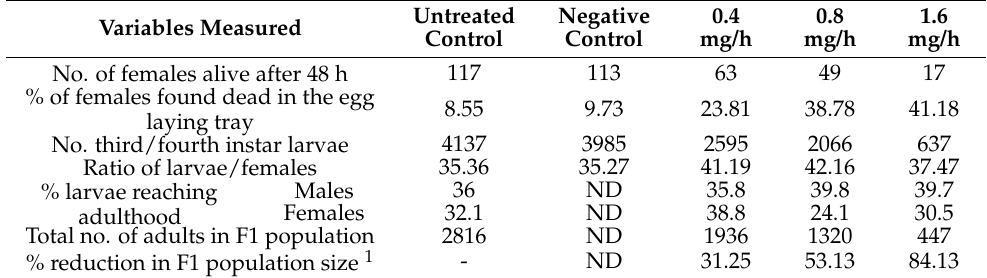
Table 5. Treatment effects on mosquito fitness and F1 population size in Cx. pipiens .